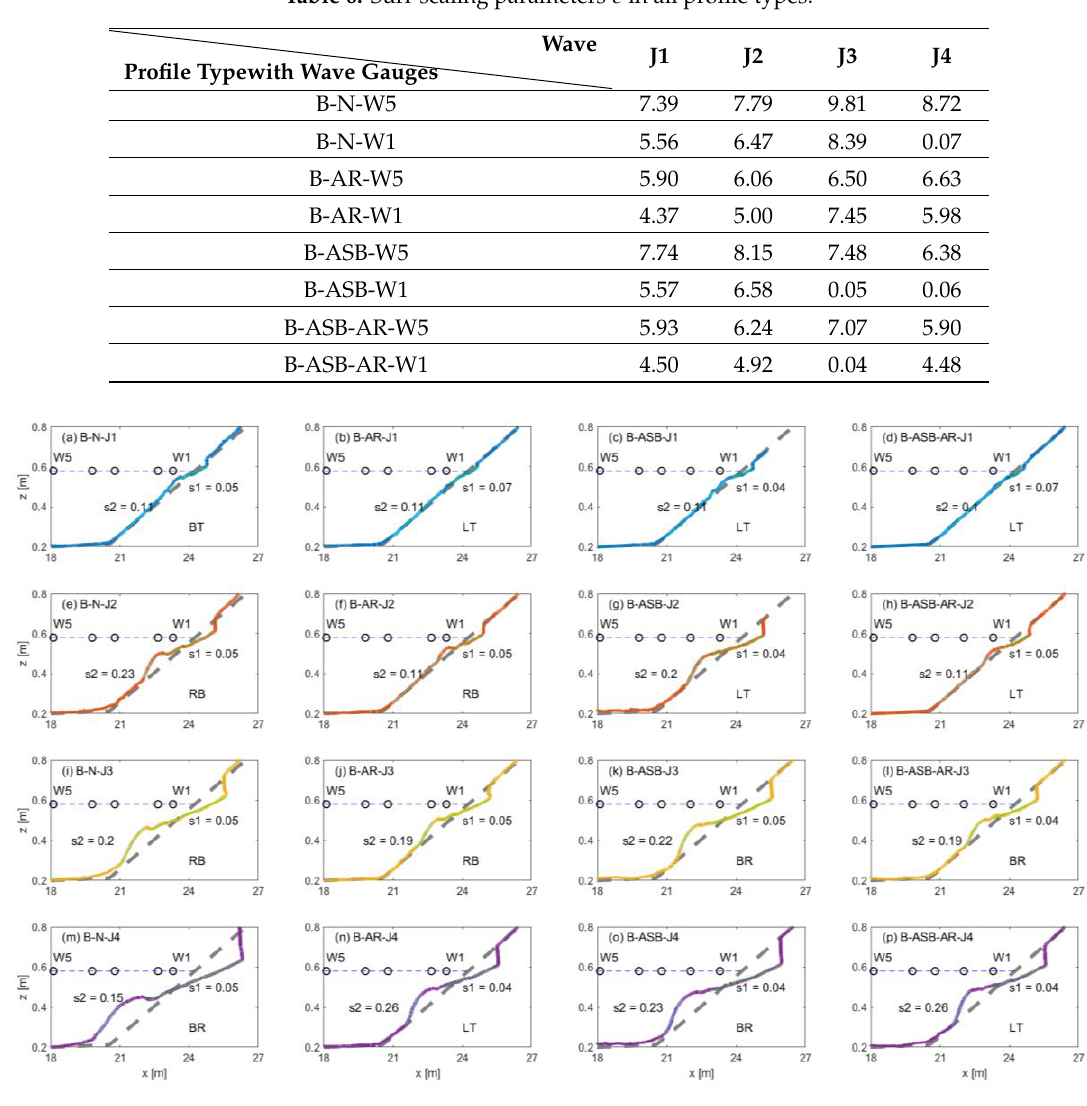
Figure 10. The morphological state identification of final profiles in all tests based on Wright and β means the beach slope Short [89] ( 𝑠 = 𝑡𝑎𝑛𝛽 means the beach slope gradient). ( s = tan